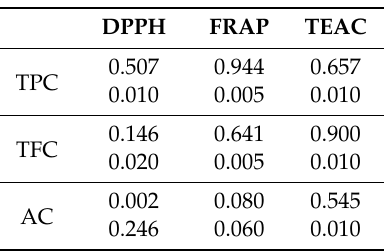
Table 4. Regression coefficients and p -values of TPCs, TFCs, and total ACs and antioxidant capacity by three different assays (DPPH, FRAP and